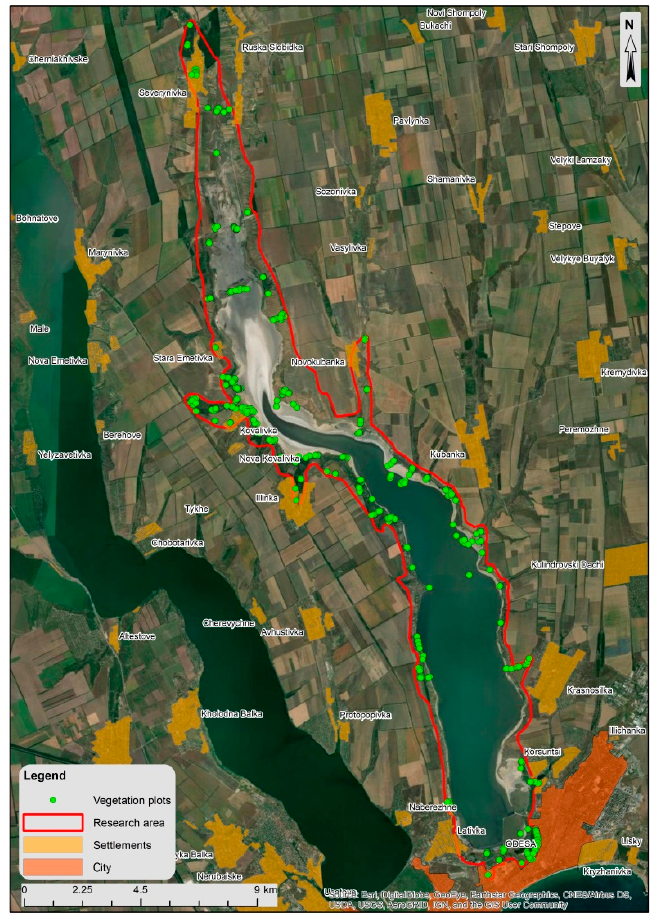
Figure 6. Schematic map of vegetation plots of the research area.